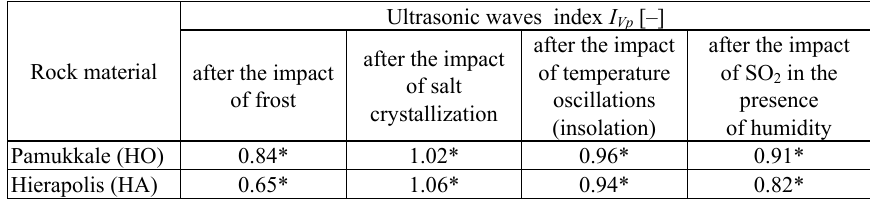
Table 2. Values of the ultrasonic waves index ( I Vp ) for the analyzed